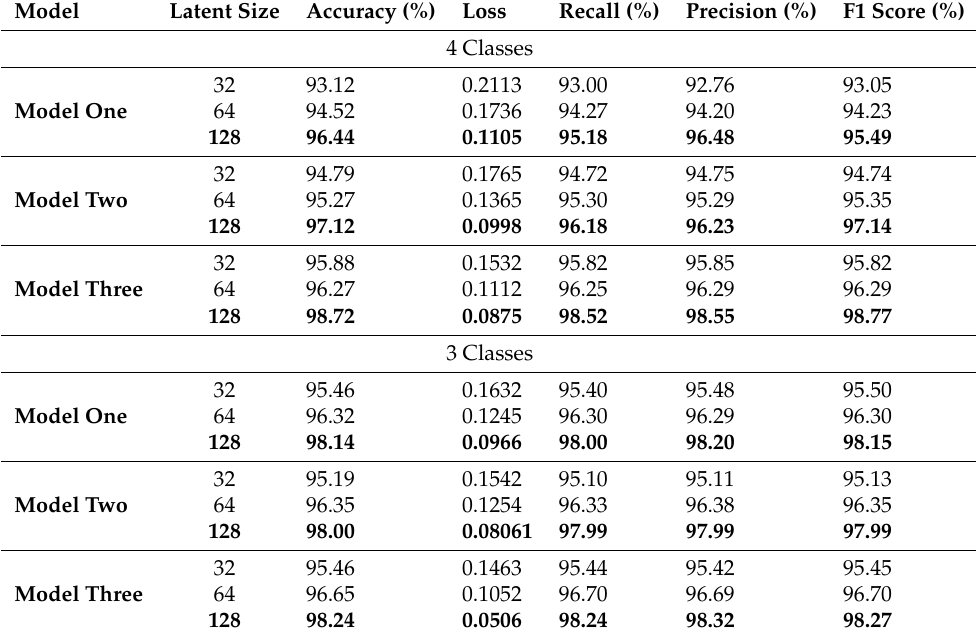
Table 11. Ablation study of different latent vector sizes on the performance of the model. La- tent size of 128 achieved the best performance among all the models. (Optimizer = Adam; Learning rate = 0.00003; Epochs = 20; set = validation dataset).